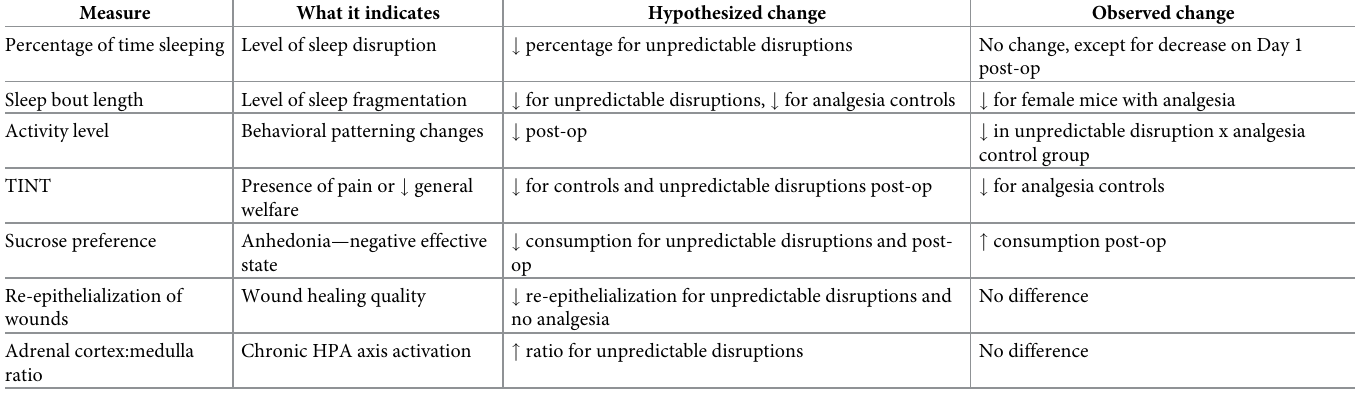
Measures, what they indicate, our hypothesized changes, and observed